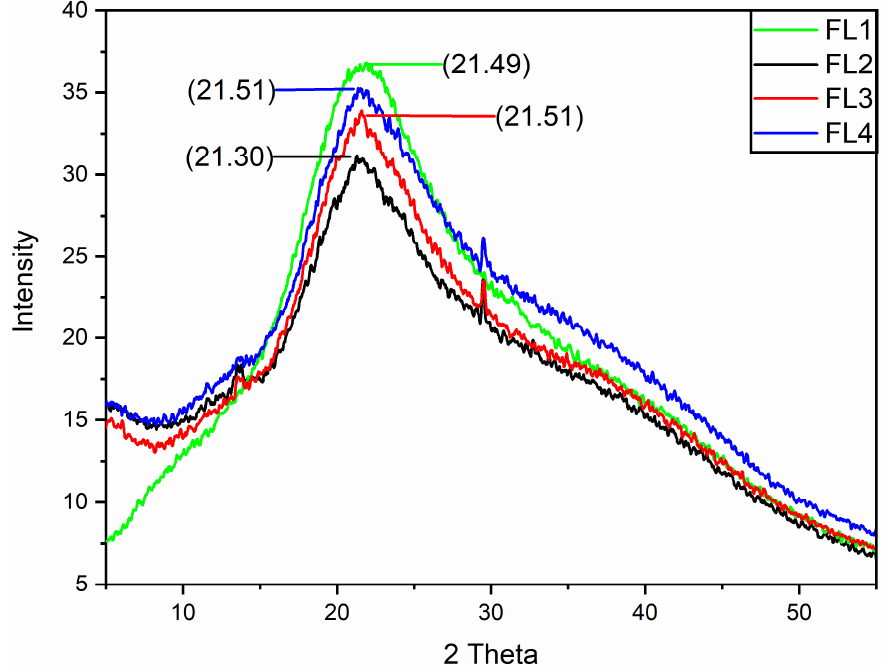
Figure 2. XRD analysis of FL1–FL4 samples: control or FL1 (CA + SA); FL2: CA + SA + OEO (1.5% v/v); FL3: CA + SA + OEO (2 % v/v); FL4: CA + SA + OEO (2.5% v/v).